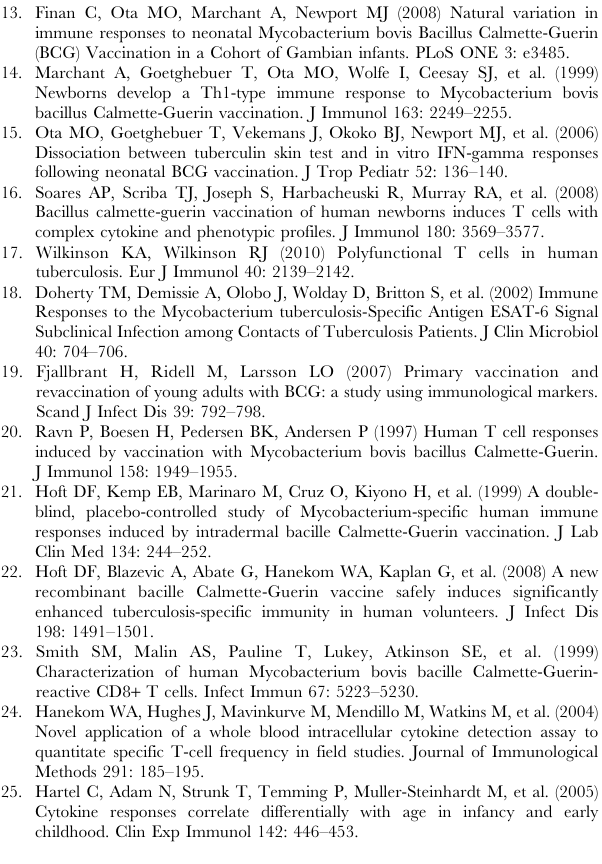
weeks after BCG immunisation. Whole blood of 13 children was incubated for 7 hours in the presence of the antigens BCG or PPD. Values for BCG- and PPD-stimulated samples were corrected by subtracting the concentration in the unstimulated (NIL) sample. Statistical differences with p-values , 0.05 are shown in red. Bars indicate medians. (TIF) Figure S2 Concentrations of cytokines and chemokines in supernatants from adults before (grey) and 10 weeks after BCG immunisation. Whole blood of 13 adults was incubated for 7 hours in the presence of the antigens BCG or PPD. Concentrations for BCG- and PPD-stimulated samples were corrected by subtracting the concentration in the unstimulated (NIL) sample. Statistical differences with p-values , 0.05 are shown in red. Bars indicate medians.